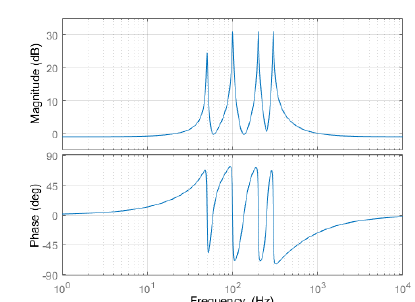
Figure 10. Amplitude and frequency characteristic curves of the quasi-PR (proportional resonant) controller model.